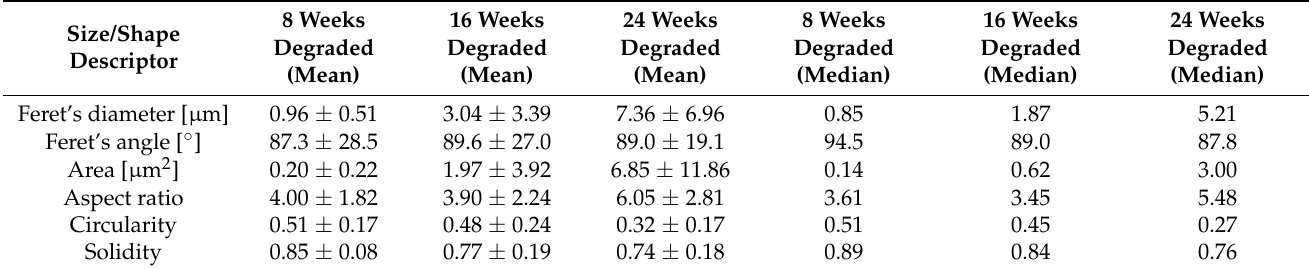
Figure 4. Top surface of a non−degraded stent imaged by ( a ) SEM and ( b ) atomic force microscope. Top surface of a stent after 24 weeks of degradation imaged by ( c ) SEM and ( d ) atomic force microscope. Table 2. Morphological characteristics of the